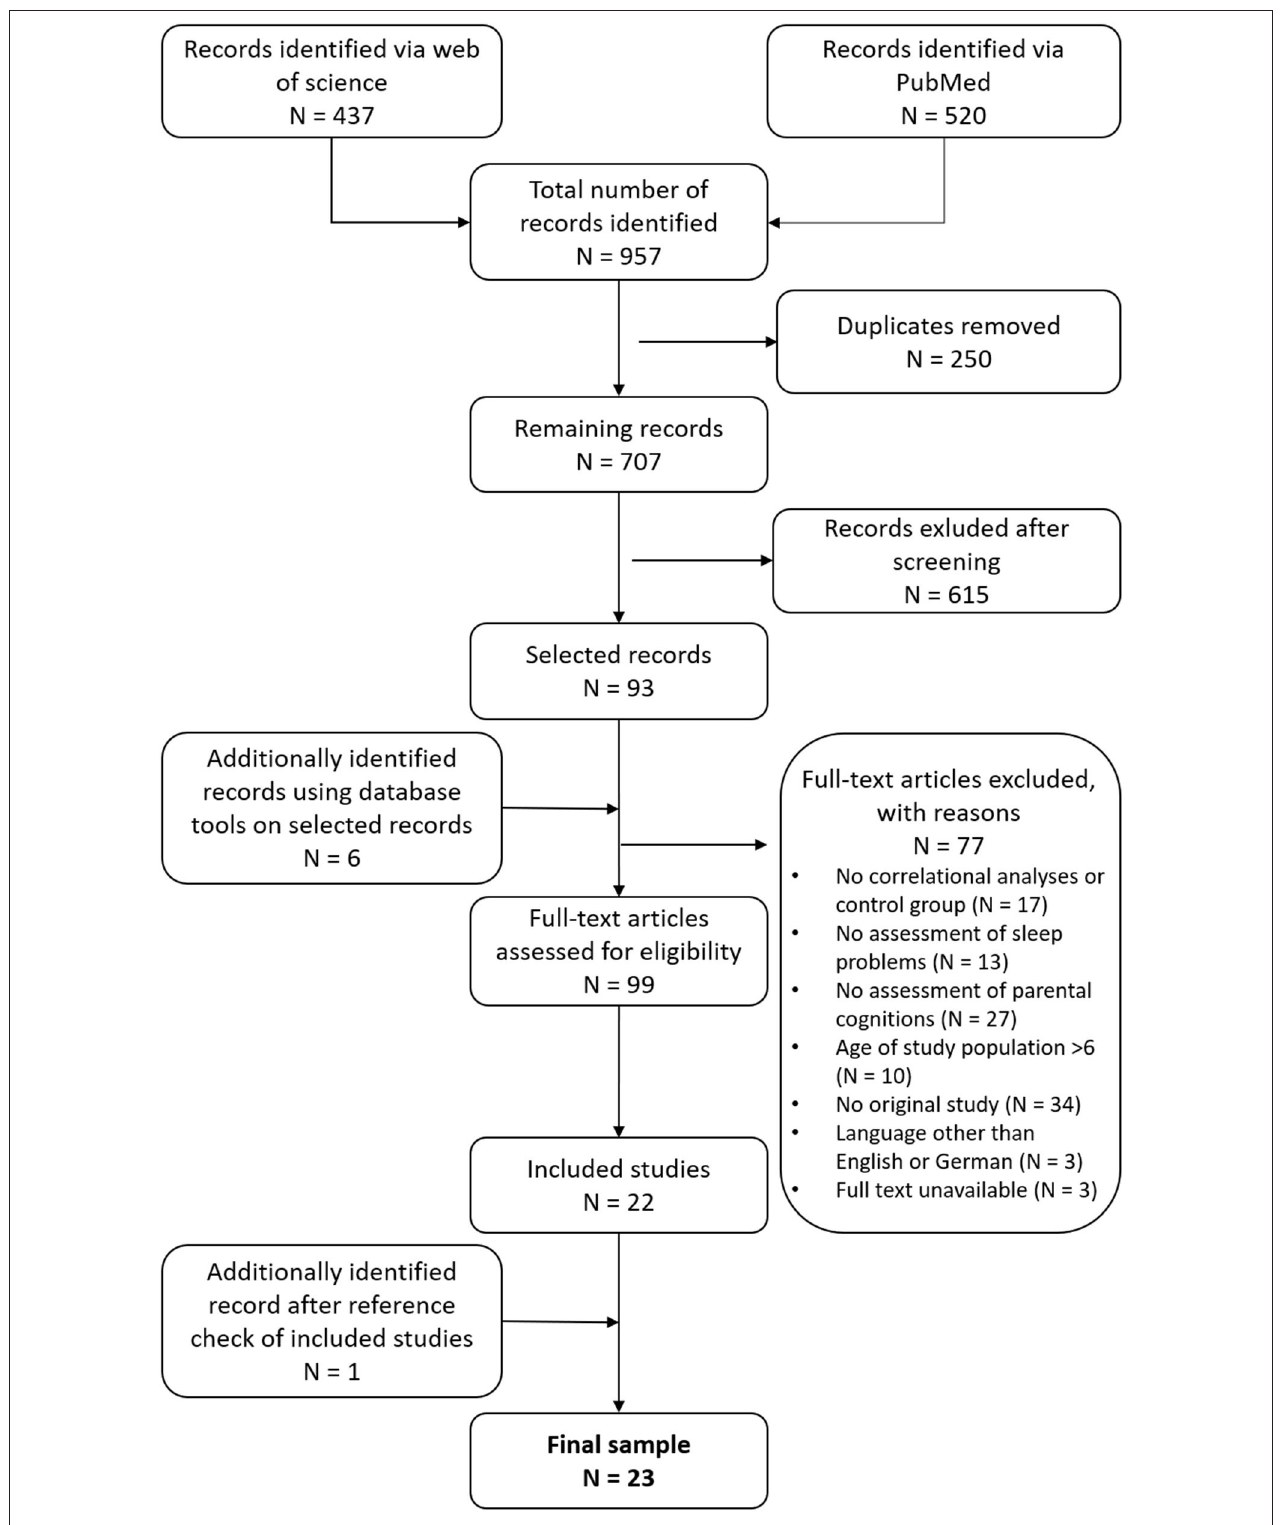
FIGURE 1 | Flow chart of study